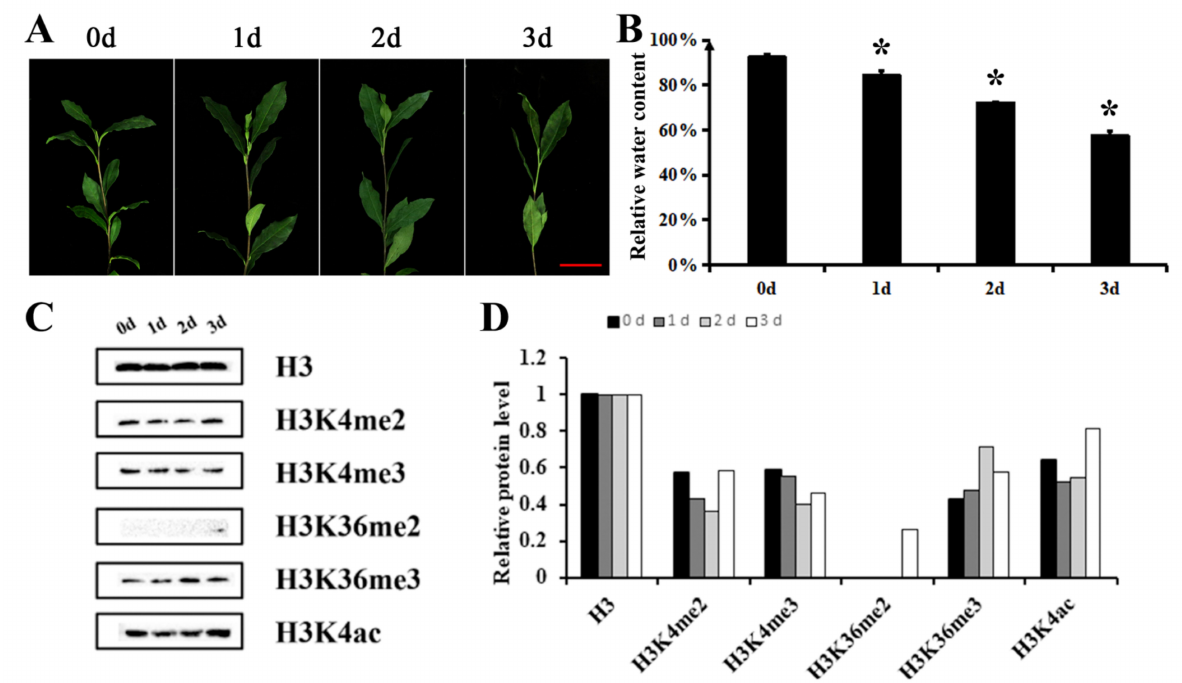
Figure 1. Histone methylation analysis of tea leaves in response to hyperosmotic treatment (20% PEG 6000) for Days 0, 1, 2 and 3. ( A ) Images of tea leaves after hyperosmotic treatment. Bars = 50 mm. ( B ) Relative water content of tea leaves after hyperosmotic treatment. ( C ) Histone modifications of lysine 4 and lysine 36 on histone H3 protein. H3K4me2: Di-methylation of lysine 4 on histone H3 protein. H3K4me3: Tri-methylation of lysine 4 on histone H3 protein. H3K36me2: Di-methylation of lysine 36 on histone H3 protein. H3K36me3: Tri-methylation of lysine 36 on histone H3 protein. H3K4ac: Acetylation of lysine 4 on histone H3 protein. H3 protein is the loading control. ( D ) Semi-quantitative analyses of western blot results in ( C ). The protein content was determined by normalizing the band intensity of specific antibodies using the software IMAGEJ. * represents significant difference at p < 0.05 versus the 0d sample. The results were obtained from three biological experiments with three technical